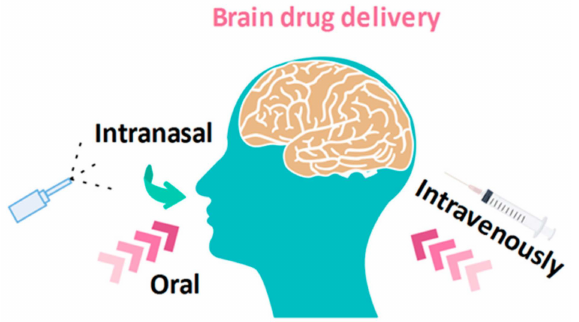
Figure 3. The demand for more e ff ective therapeutics has led to the development of multiple strategies to reach the brain